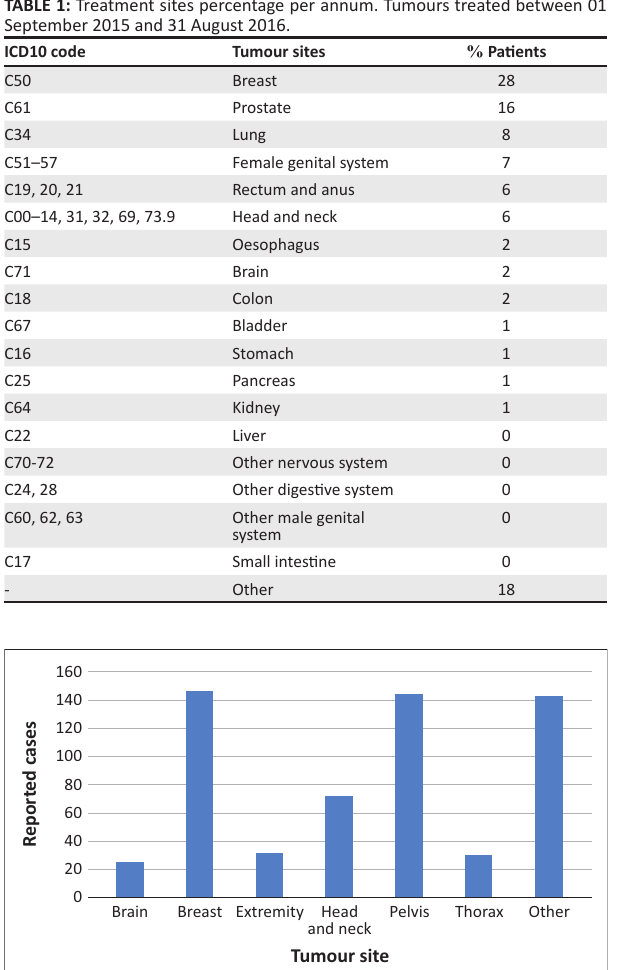
FIGURE 6: Incident reports received per tumour site.